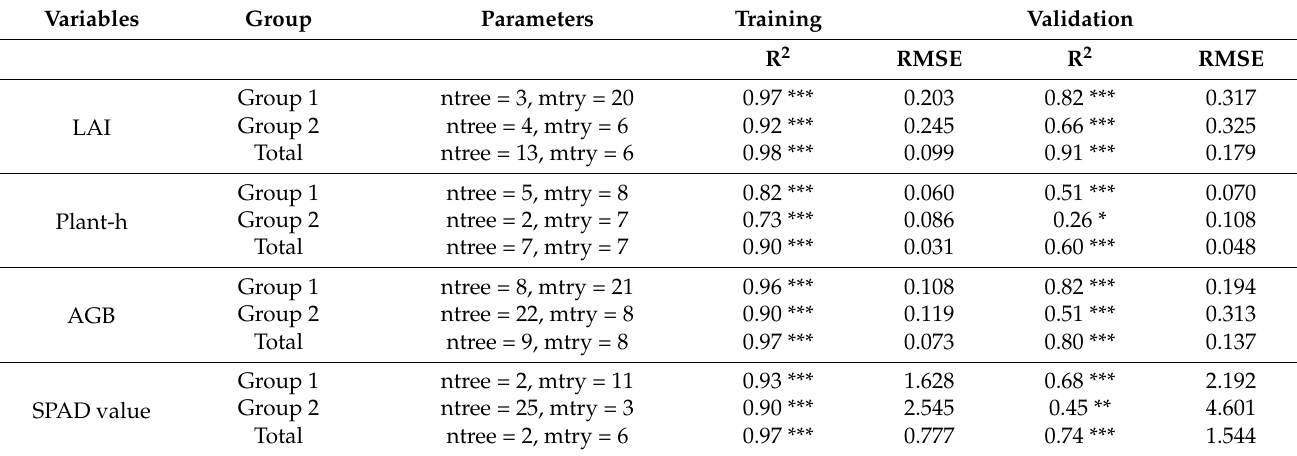
Table 10. Outcomes of calibration and validation models of random forest for the association between V-SRIs extracted from in situ spectrometry and satellite imagery and leaf area index, plant height, above ground biomass and SPAD value before selecting the best features.